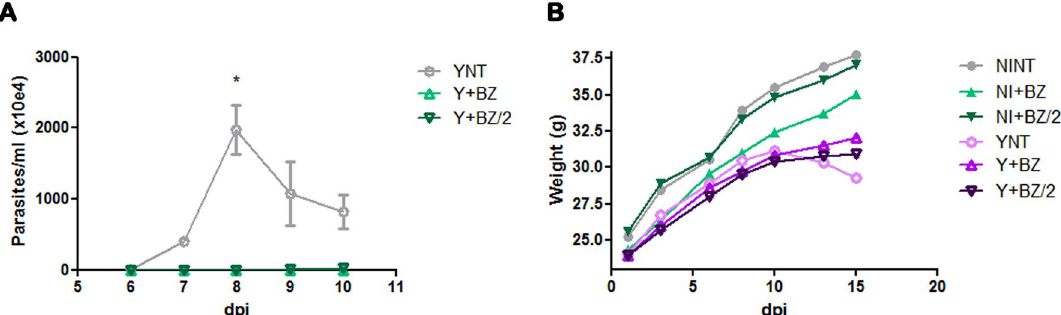
Figure 1. Characterization of the experimental model (Swiss Webster/Y strain). The following parameters were evaluated in a kinetic study: ( A ) parasitemia, ( B ) weight and ( C ) survivor. The parasitemia peak occurred at 8 dpi, and benznidazole treatment cleared parasitemia ( A ). T. cruzi infection induced body weight decrease in YNT group starting at 10 dpi, benznidazole treatment had no effect on this decrease ( B ). Benznidazole in both doses used impaired mortality ( C ). NI, non infected; Y, infected; NT, non treated; BZ, treated with benznidazole (100 mg); BZ/2, treated with benznidazole (50 mg); dpi, days